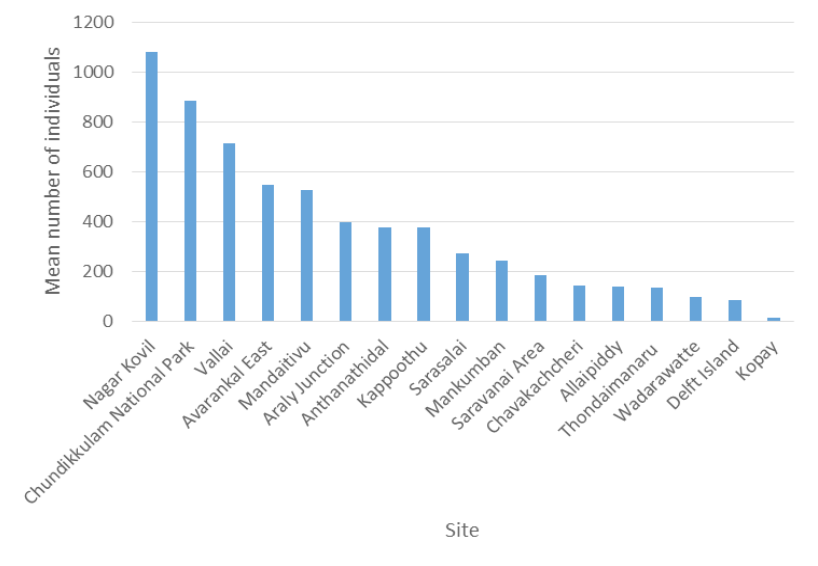
Figure 3: Mean number of Greater flamingo at each study site